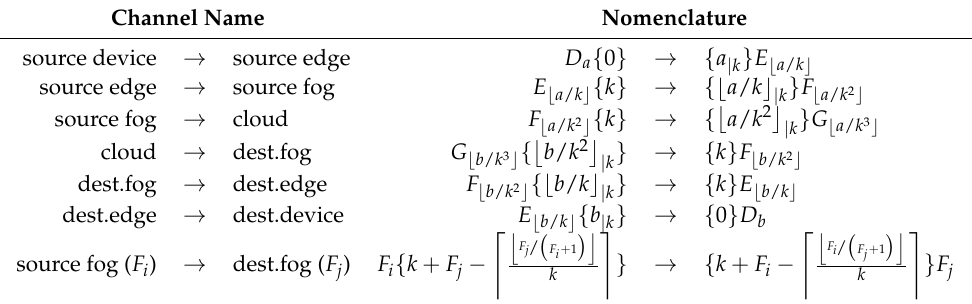
Table 4. Channels defined within the model and their nomenclature.